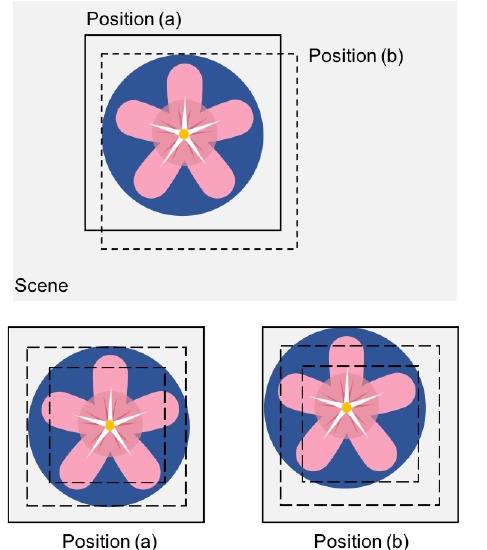
Figure 8. Analyze the color feature distribution at different positions under the multiple-layered